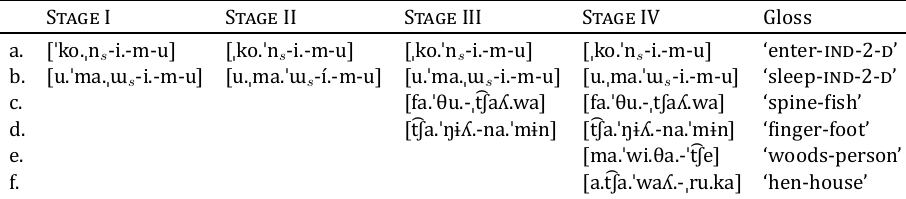
Table 24: Stem (cid:976)inal stress in verbs (right edge of stem=(cid:280)) and (cid:976)irst P(cid:279)W(cid:265)-stress in compounds (secondary stress marks denote ‘demoted’